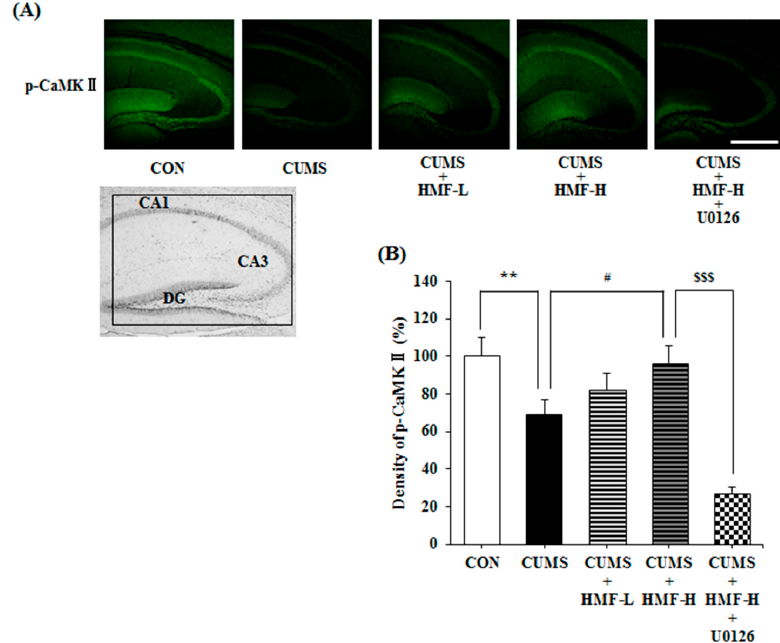
Figure 9. Influence of HMF on the levels of p-CaMK II in the CUMS-treated mouse hippocampus on Day 16. ( A ) Immunoreactivity of phosphorylated calcium-calmodulin-dependent protein kinase (p-CaMK) II (green). The white scale bar shows 500 µ m. The portion for the quantitative analysis was shown with a black square. ( B ) A quantitative analysis of p-CaMK II densities. Values are means ± SEM ( n = 6–8). Symbols show significant differences between the following groups: CON vs. CUMS (** p < 0.01, the Student’s t -test), CUMS vs. CUMS + HMF-H ( # p < 0.05, one-way ANOVA followed by the post-hoc Williams multiple comparison test) and CUMS + HMF-H vs. CUMS + HMF-H + U0126 ( $$$ p < 0.001, the Student’s t